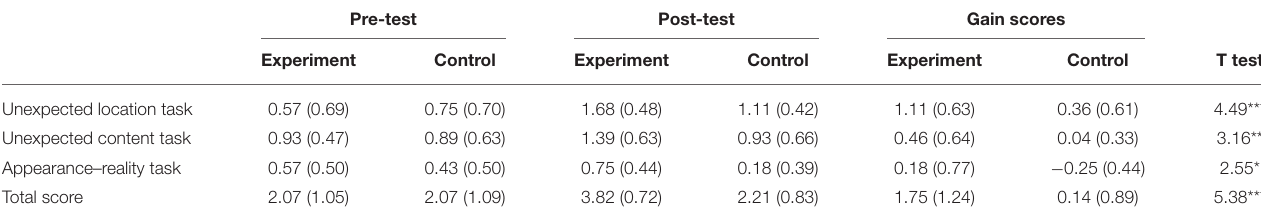
TABLE 2 | Means and standard deviations for the ToM tasks in pretest and posttest.